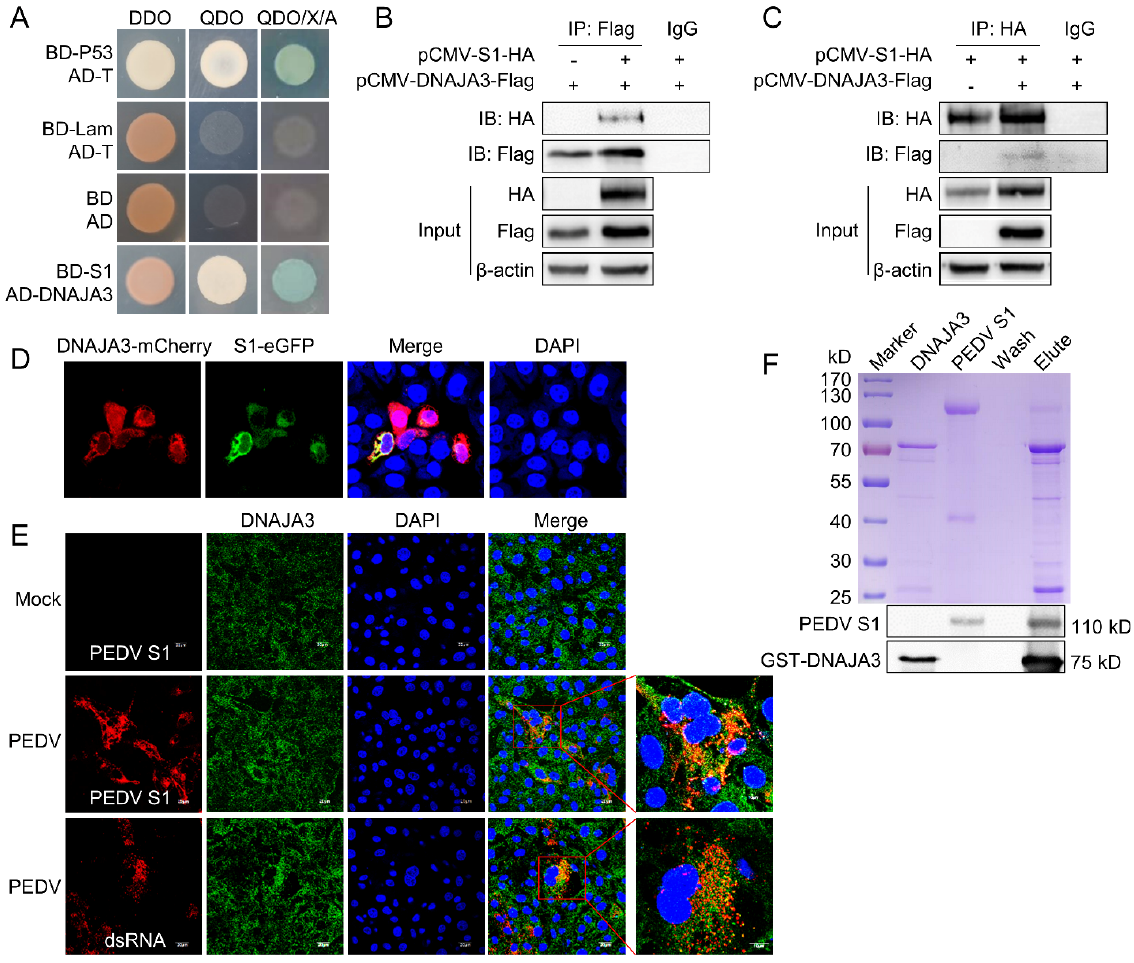
Figure 1. DNAJA3 protein interacted with PEDV S1. ( A ): Yeast strain Y2HGold was co-transformed with bait plasmid pGBKT7-S1 (BD-S1) and prey plasmid pGADT7-DNAJA3 (AD-DNAJA3). The blue bacterial lawn growing on the QDO/X/A plates represents positive interactions. Co-transformation of pGBKT7-53 (BD-p53) and pGADT7-T (AD-T) served as positive control, pGBKT7-Lam (BD- Lam) and pGADT7-T, as negative control, and pGBKT7 (BD) and pGADT7 (AD), as blank. DDO, SD/ − Leu/ − Trp; QDO, SD/–Ade/–His/–Leu/–Trp; QDO/X/A, SD/–Ade/–His/–Leu/–Trp/X- a-Gal/AbA. ( B , C ): HEK293T cells were transfected individually or co-transfected with plasmids expressing S1-HA and DNAJA3-Flag for two-way Co-IP. Cell lysates were immunoprecipitated with mouse anti-Flag or rabbit anti-HA mAb, followed by immunoblotting with rabbit anti-Flag pAb or mouse anti-HA mAb to reveal S1 and DNAJA3, respectively. ( D ): Confocal images showing colocal- ization of DNAJA3 and S1 in the cells transfected with pCMV-DNAJA3-mCherry and pCMV-S1-eGFP. ( E ): Colocalization of endogenous DNAJA3 and S1 in PEDV-infected IPEC-J2 cells. ( F ): GST-pull-down: GST-DNAJA3 and PEDV S1 protein were mixed and incubated overnight, and then bound with GSH-purification resin. The eluates were detected by Coomassie blue staining (top) and Western blotting (bottom) using mouse anti-GST and anti-S1 mAb. To identify the regions of S1 that are responsible for the specific interaction with DNAJA3, a series of deletion mutants of S1 were constructed (Figure 2A). A Co-IP assay showed that S1 fragments 1–479 (T3) and 1–649 (T4) were able to interact with DNAJA3, similar to the S1 full-length, but those from 1–279 (T1) or 1–379 (T2) were not, suggesting that the middle fragment from the second half of S1 between aa379 and aa479 is required for interaction with DNAJA3 (Figure